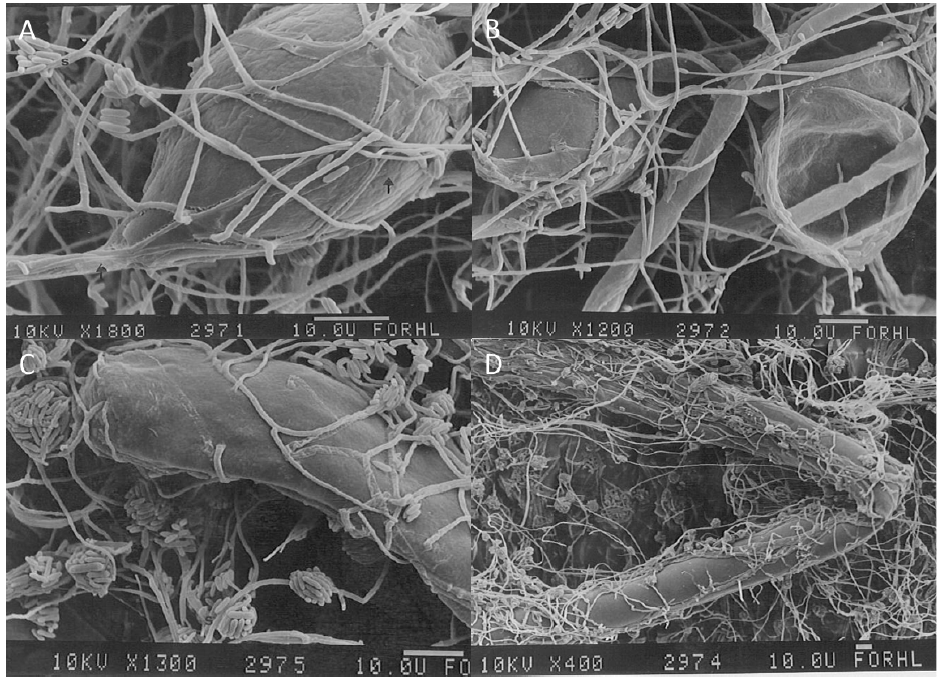
Figure 8. Top ( A ) Intermediate mycoparasitic stage of L. muscarium against Phytophtora palmivora : arrows show the contact between the thin mycelium of the Antarctic fungus and a P. palmivora sporangium; s = spores of L. muscarium . ( B ) Late mycoparasitic stage of L. muscarium against P. palmivora ; the oomycete appeared completely overwhelmed by the fungus. Bottom. ( C ) Intermediate mycoparasitic stage of L. muscarium against Mucor mucedo : the Antarctic fungus (thin mycelium) establishes firm contact with the host (thick mycelium) and penetrates it. ( D ) Late mycoparasitic stage of L. muscarium against M. mucedo : the host appears completely overwhelmed. Extensive sporulation of L. muscarium is always recorded (modified from